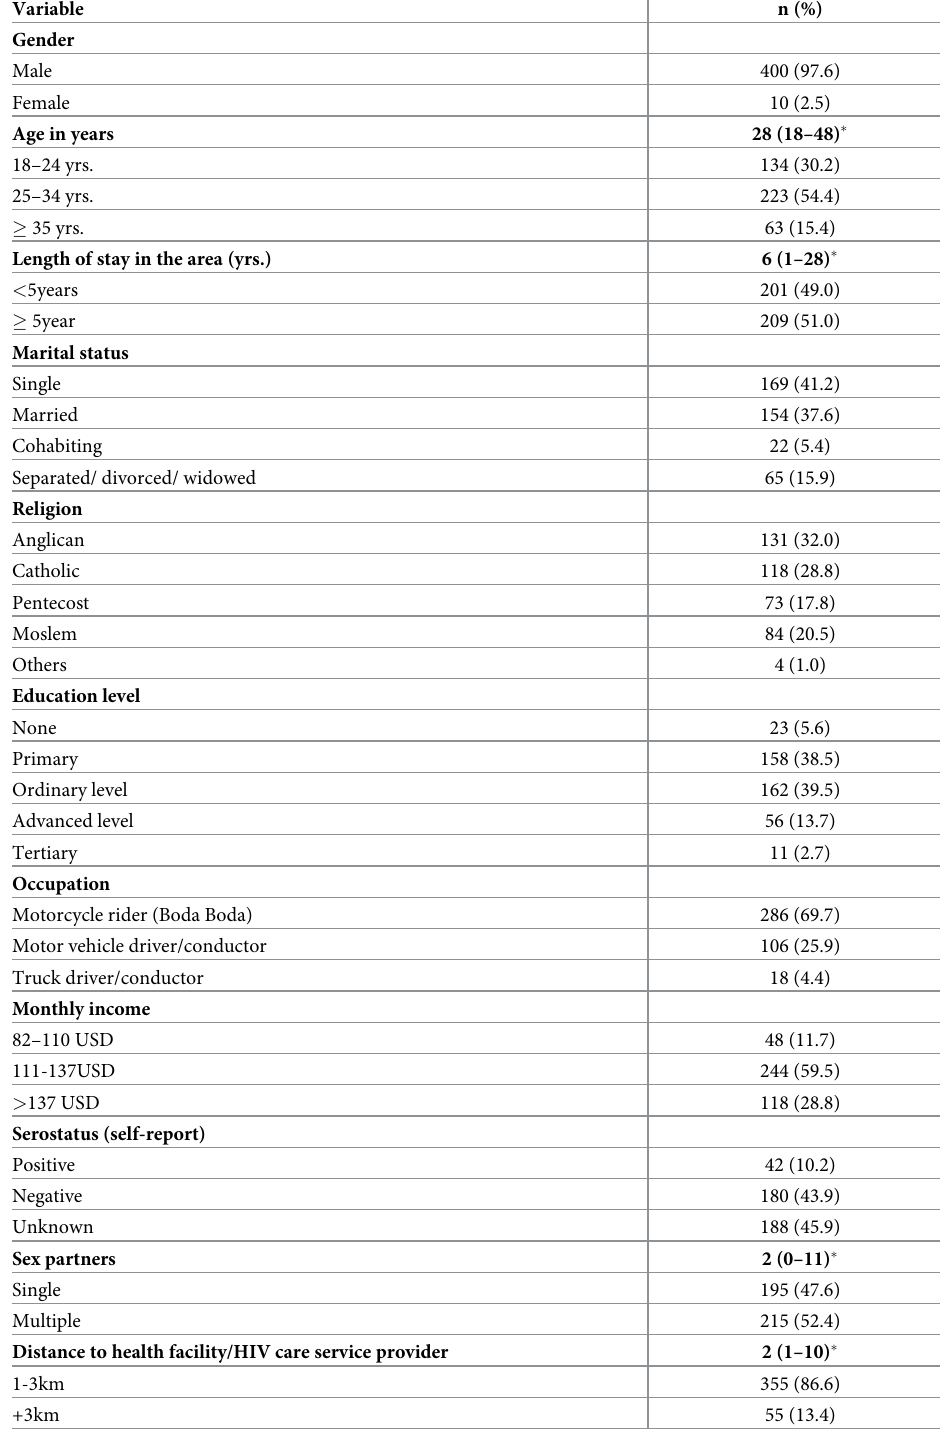
Table 2. Demographic characteristic of the